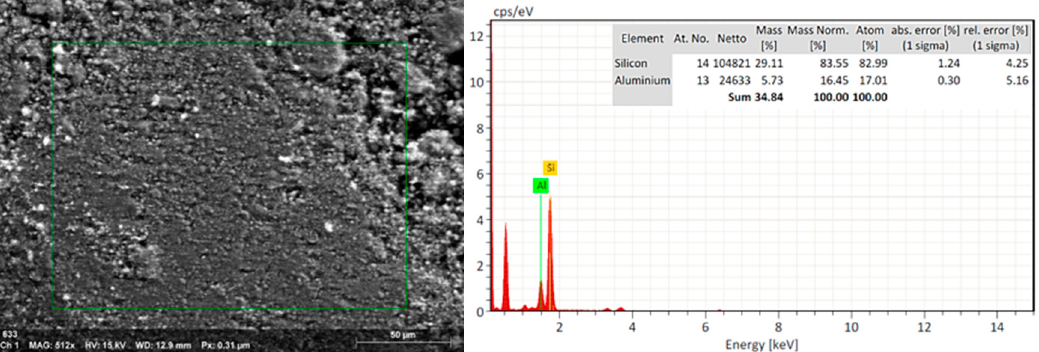
Figure 2. SEM-EDX. EDX analysis of the nZ sample without treatment.